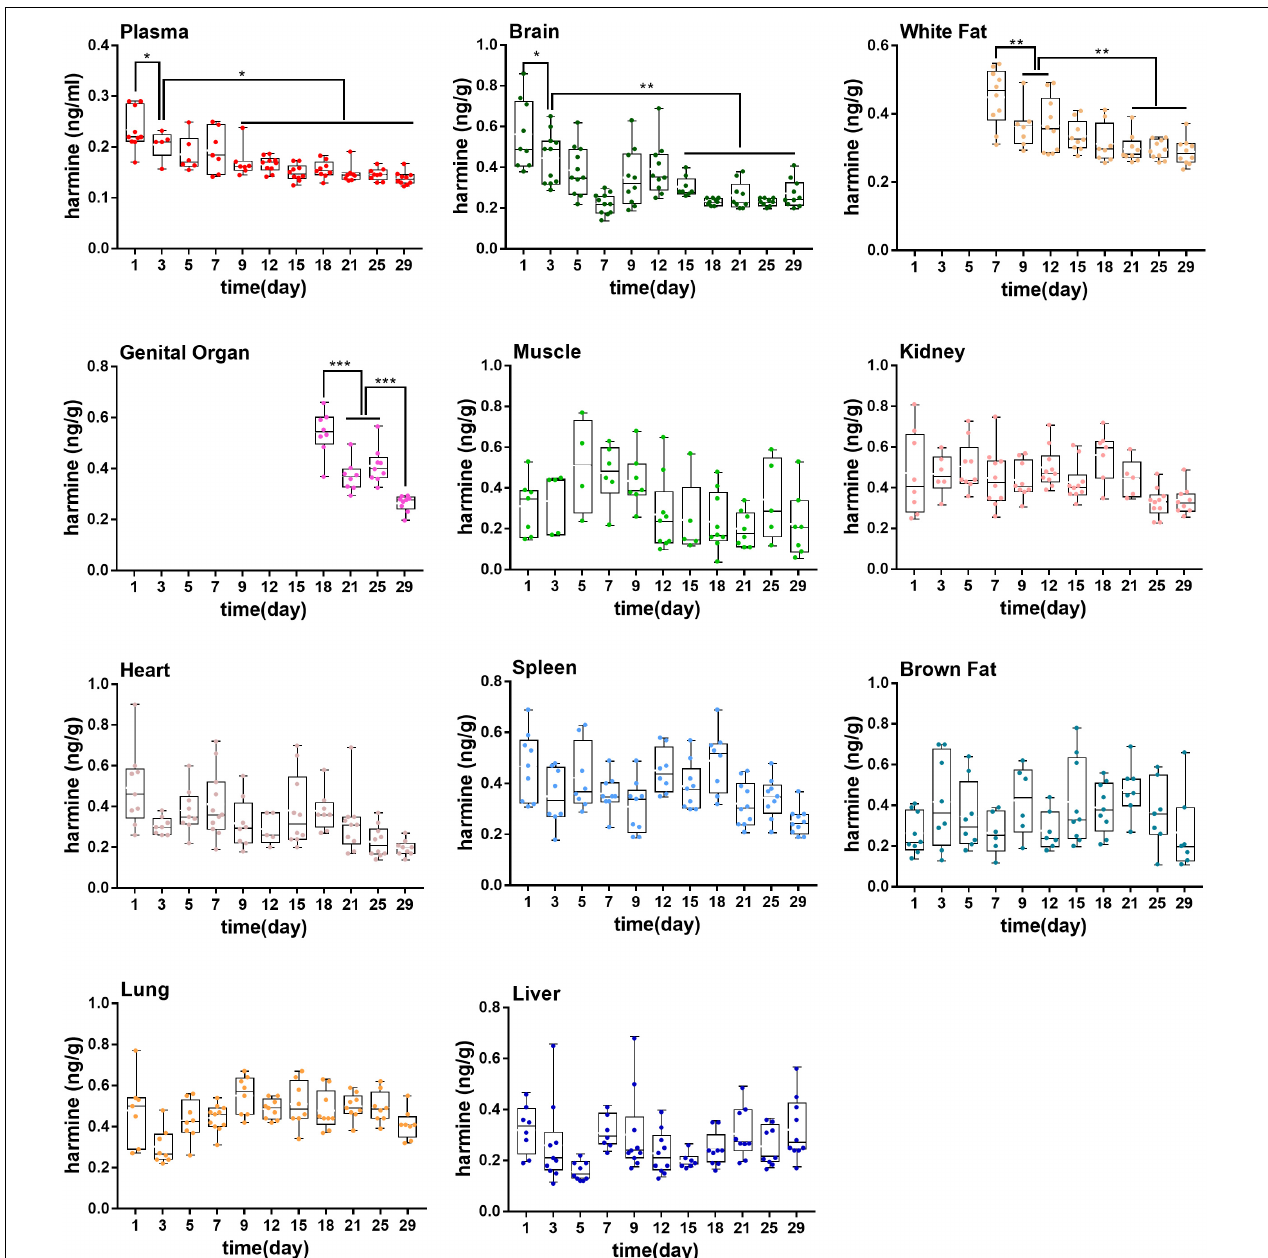
FIGURE 3 | Concentrations of harmine in rat plasma during the growth of 18-month-old rats (from youth to old stage). * P < 0.05, ** P < 0.01, *** P <